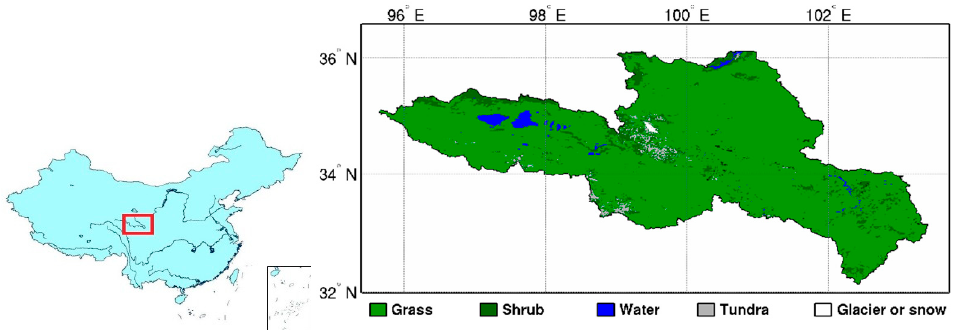
Figure 1. Location and land use of the Source Region of the Yellow River (SRYR). The regular meteorological and eddy covariance observations from the SRYR Alpine Climate Stations (102 ◦ 08 (cid:48) E, 33 ◦ 53 (cid:48) N, 3443 m) were used from 1 August 2019. The